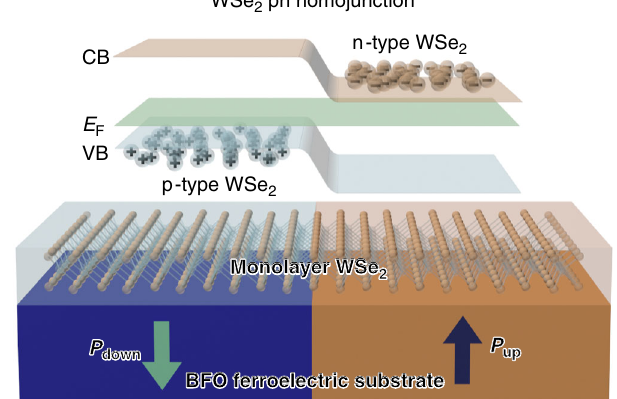
Fig. 1 Schematic band diagram of a WSe 2 pn homojunction derived from a ferroelectric-pattern-assisted BFO layer. Both polarization states ( P down and P up ) on a ferroelectric BFO layer can directly affect the carrier type of monolayer TMD with either p-type or n-type semiconducting